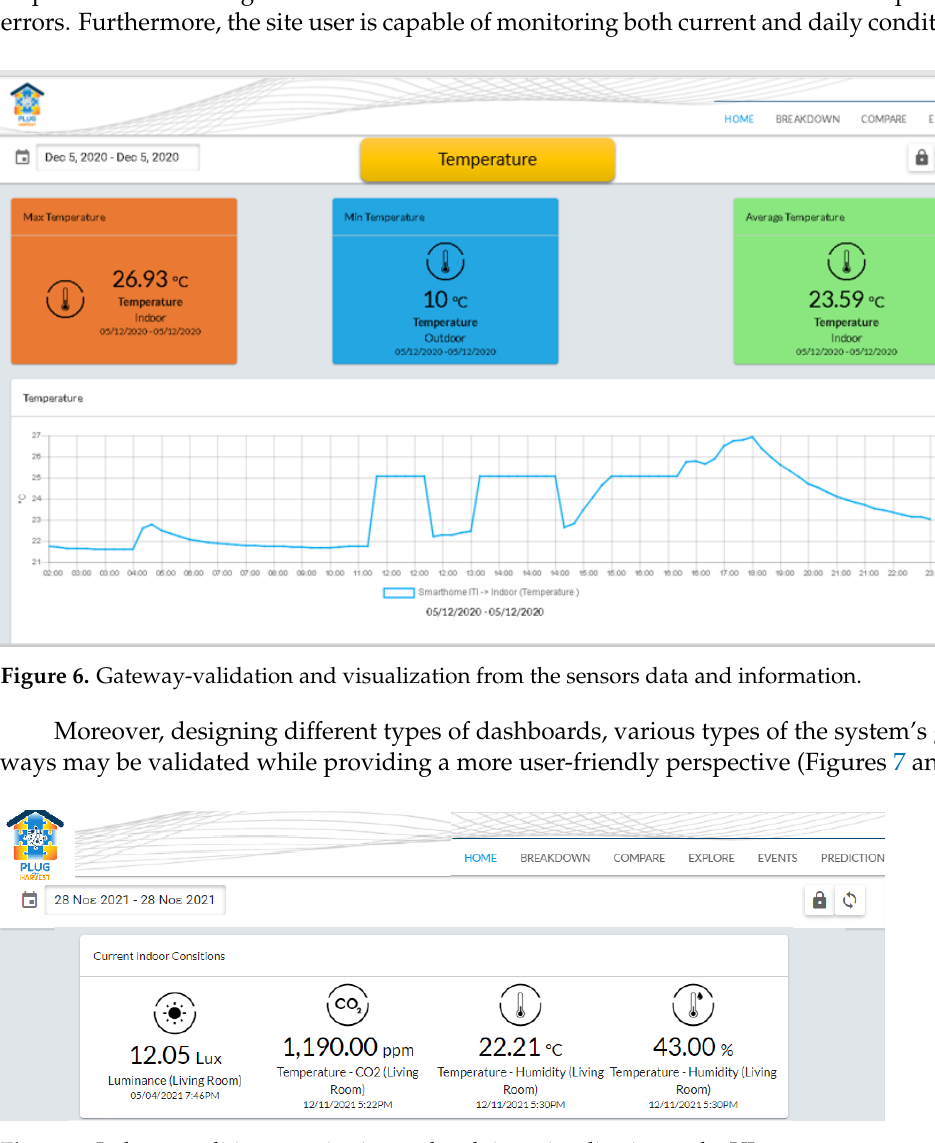
Figure 7. Indoor-conditions monitoring and real time visualization to the UI.